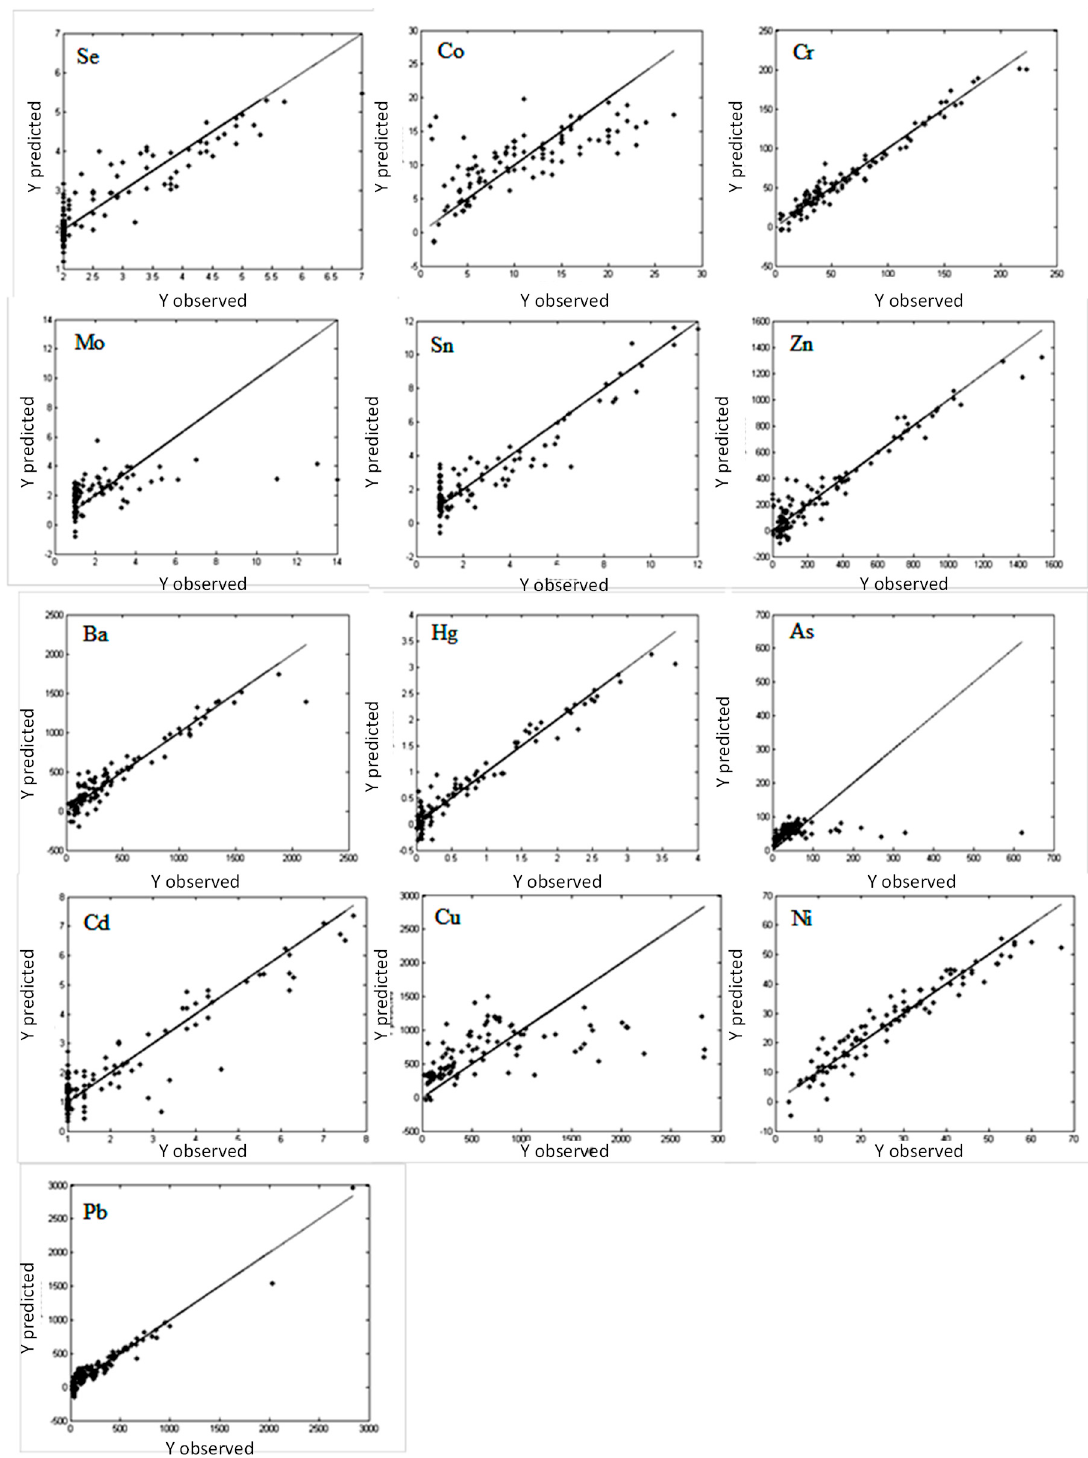
Figure 7. The PLS model describing the relationship between the metal content in soil and spectral data measured using the Near Integrated Sphere and DRIFT technique in the NIR. In Table 4, errors achieved for each range were compared. Table 4. Comparison of RMS and RMSCV values for PLS models based on each infrared range. (highest values of errors were marked with dark colors).